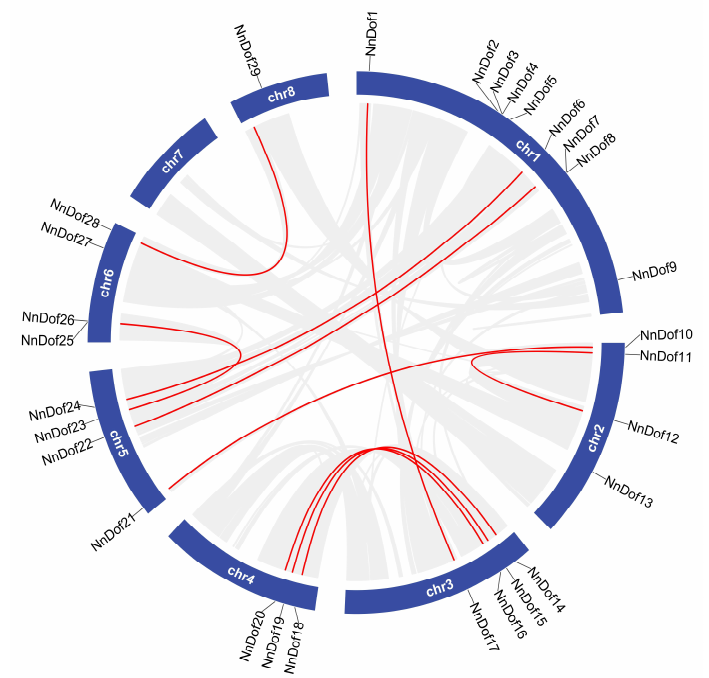
Figure 6. Chromosomal locations and segmental duplication events of NnDofs. Red lines represent segmental duplication events.